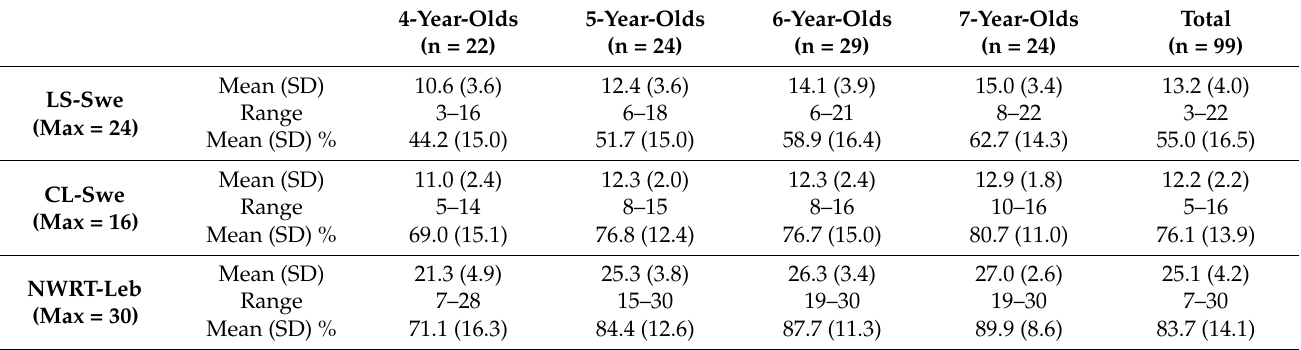
Table 6. Mean scores, standard deviations (SD), ranges, mean accuracies in %, and SDs for each NWR task by age groups and total